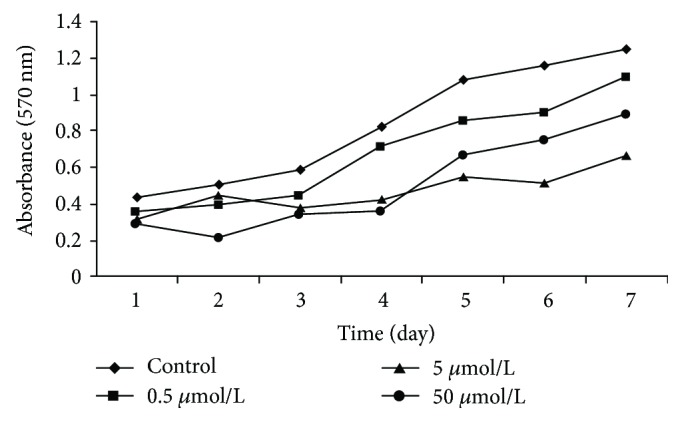
SKOV3 cell proliferation in a time- and dose-dependent manner.